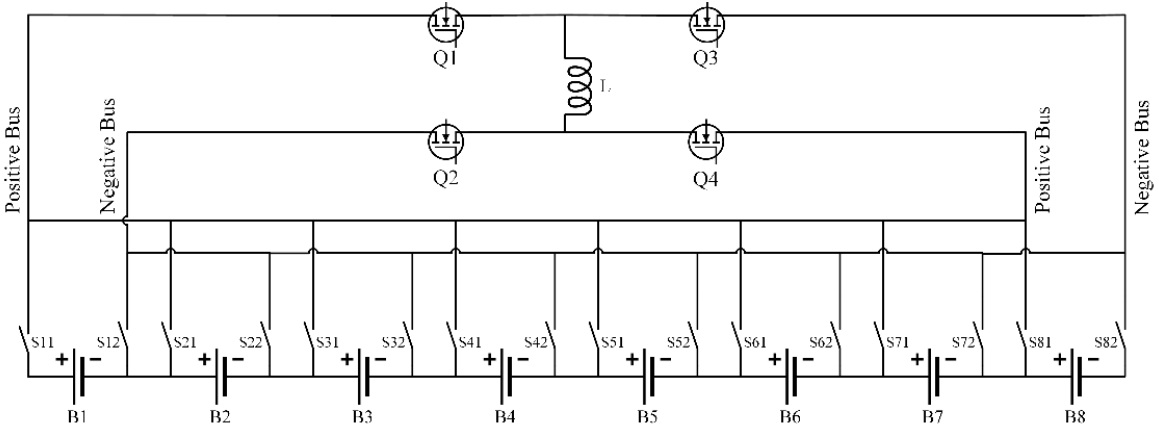
Figure 1. Main circuit of the proposed topology.